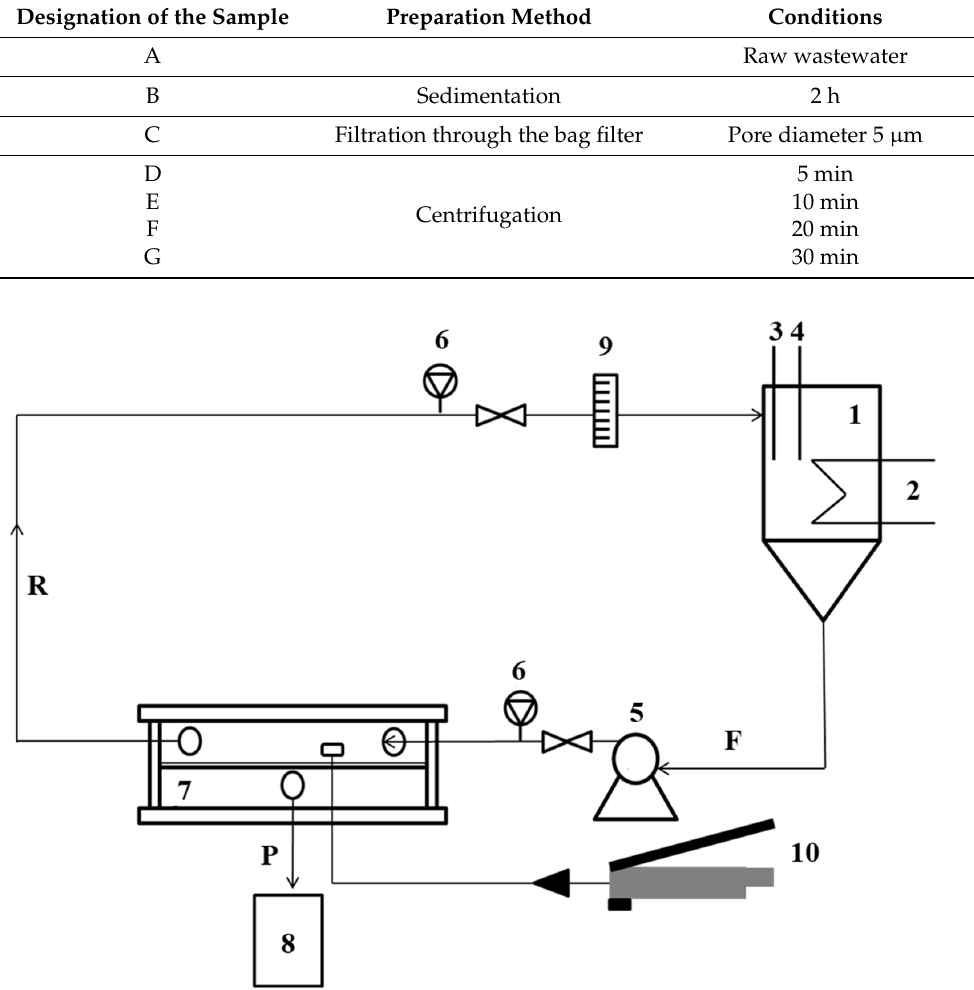
Table 2. Designation of PPW samples vs. sewage treatment methods used.